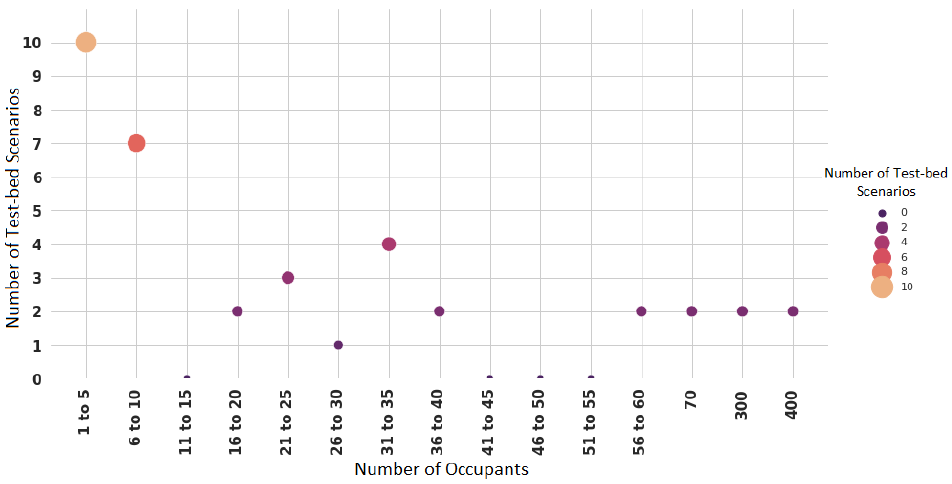
Figure 13. Test-bed scenarios by occupant